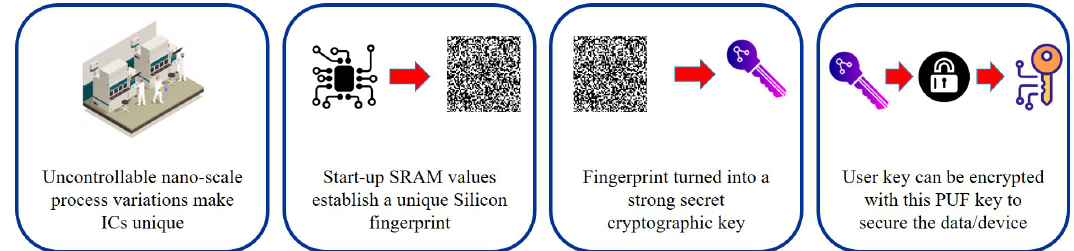
Figure 7. Flow of PUF technology used for secure key management.